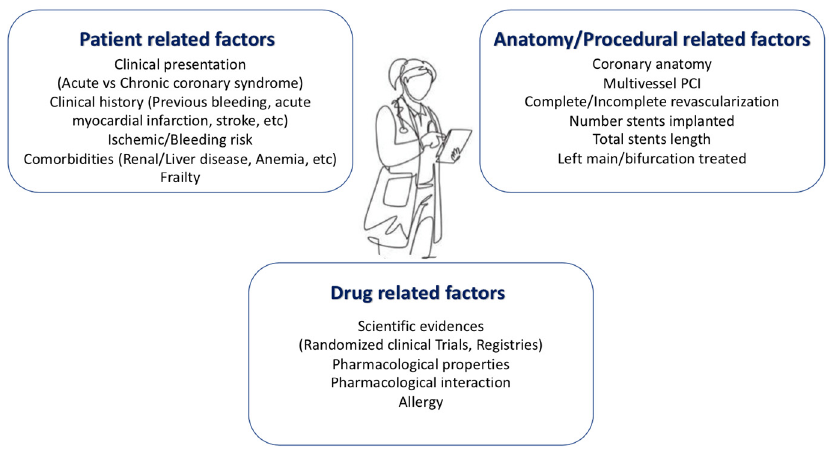
Figure 6. Factors for physicians to consider when determining the optimal antithrombotic regimen for individual patients with atrial fibrillation and acute coronary syndrome or PCI. In patients with ACS and NVAF, the safety and efficacy of DAT, consisting of a DOAC with a P2Y12 inhibitor, usually clopidogrel, have been specifically addressed in different randomized trials [9–12], reporting a significantly lower bleeding risk of DAT compared with TAT without increasing the major adverse cardiac events